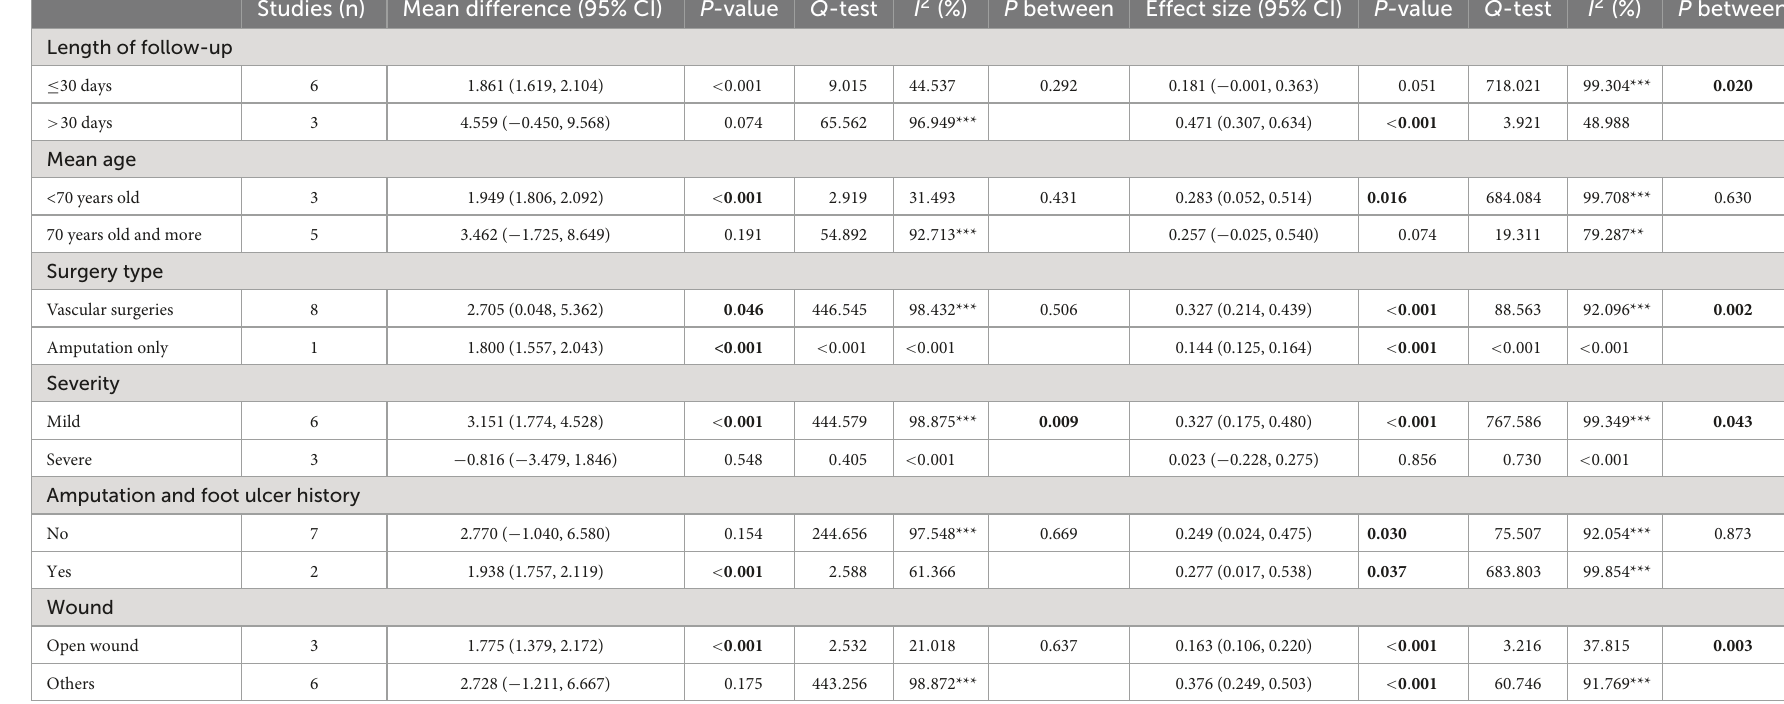
TABLE 5 Subgroup analysis on the association between frailty score and length of hospital